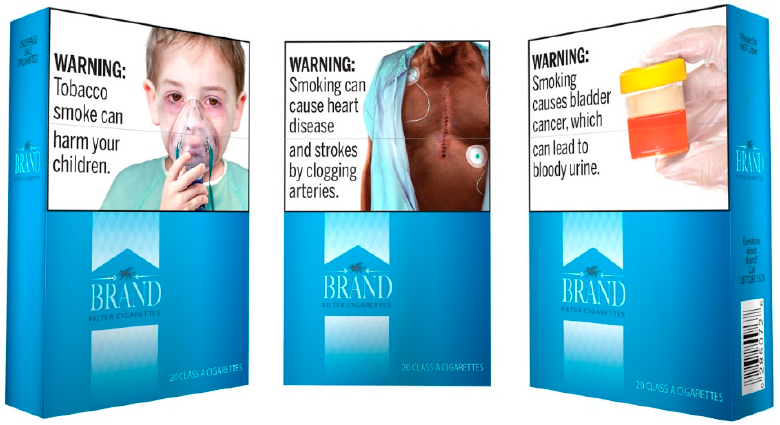
Figure 3. FDA’s proposed new cigarette warning labels [20].